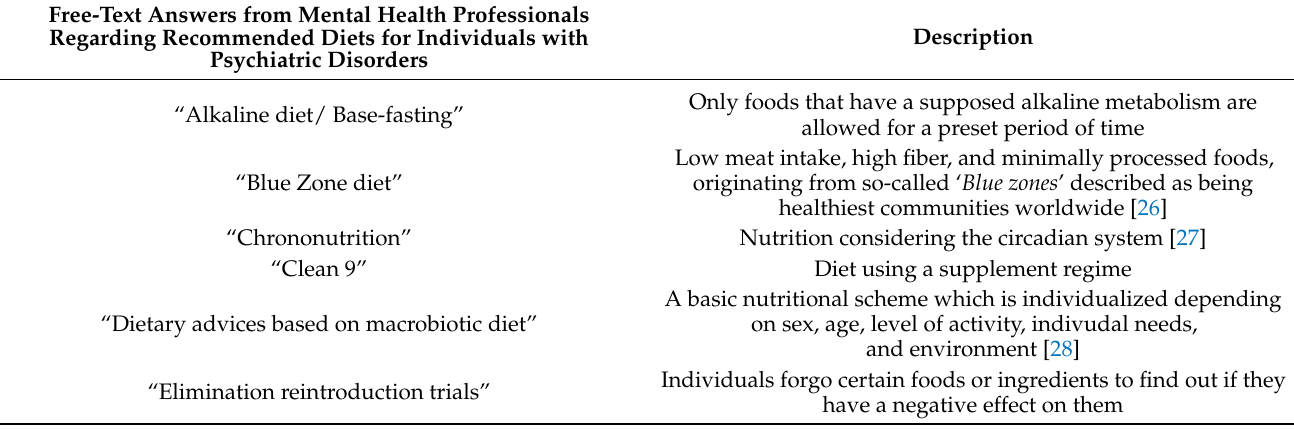
“Dietary advices based on macrobiotic